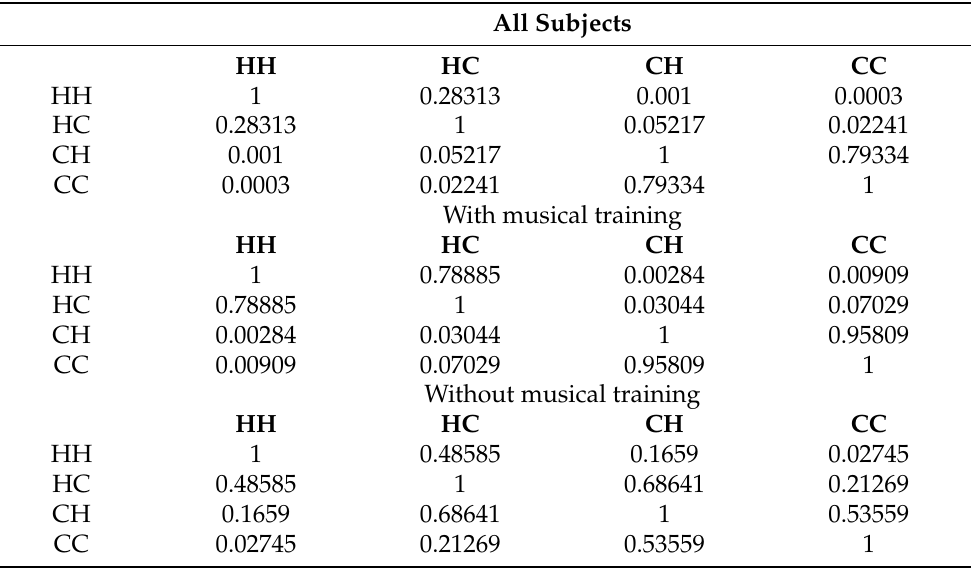
Figure 3. Boxplots summarizing the relaxation level of the different groups of participants (whole group, with and without musical training). In each box, the central mark is the median, the edges of the box are the 25th and 75th percentiles, and the whiskers extend to the most extreme data points that are not considered outliers. HH = music composed and performed by a human; HC = music composed by a human and performed by a machine; CH = music composed by a machine and performed by a human; CC = music composed and performed by a machine. w/ = with; w/o = without. ( a ) refers to all the participants; ( b ) refers to the participants without musical training; ( c ) refers to the participants with musical training. Table 3. Two-tailed Mann–Whitney U test (with α = 0.05) comparing the relaxation level achieved and considering the combinations of performer/composer (HH, HC, CH, and CC) on the entire population and the subgroups with and without musical training. HH = music composed and performed by a human; HC = music composed by a human and performed by a machine; CH = music composed by a machine and performed by a human; CC = music composed and performed by a